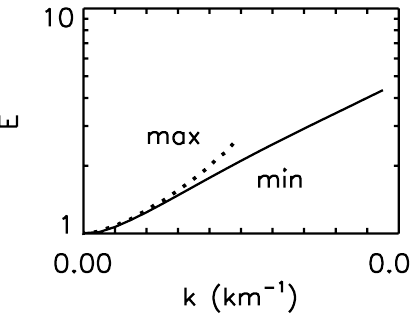
Fig. 5. Enhancement parameter (ratio of aliased to true spectrum) in the maximum (dotted line) and minimum distortion directions (solid line) for the spectrum in Fig. 4. The x-axis measures distance from the peak of the spectrum in the wave number